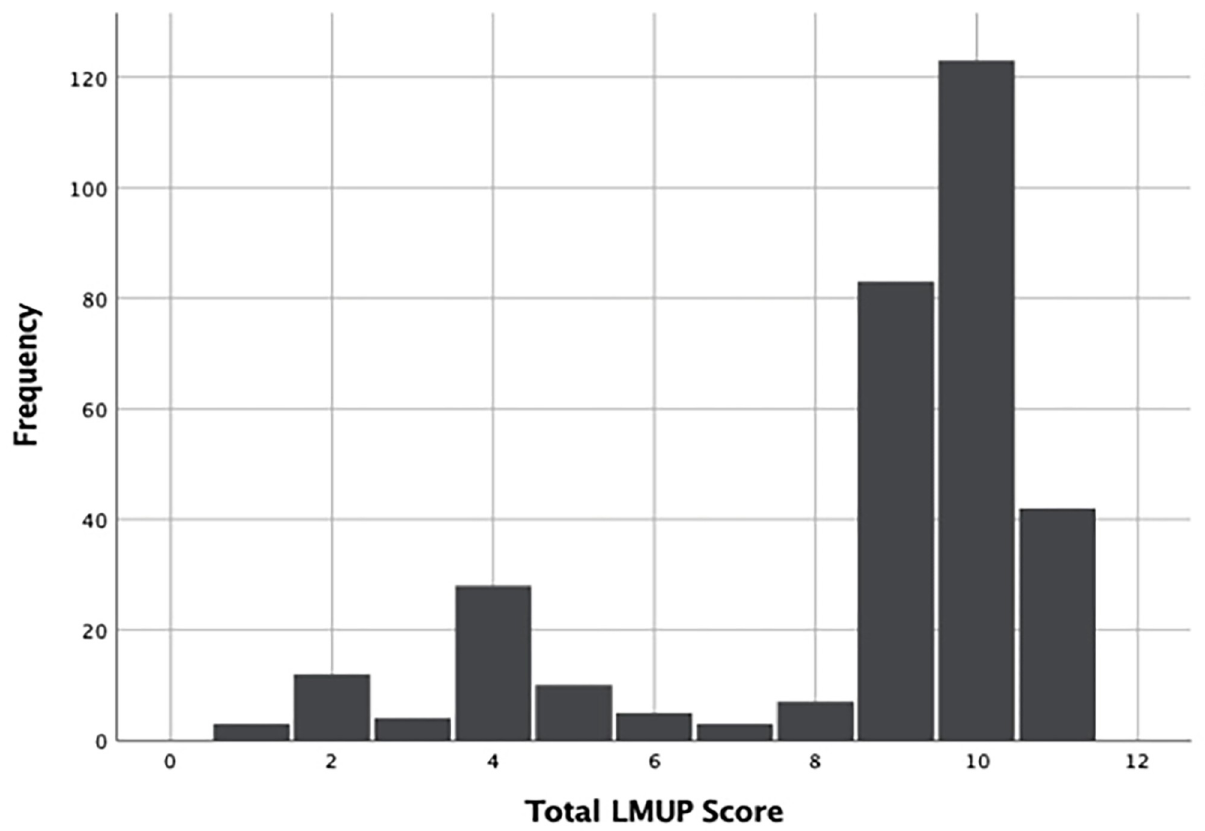
Fig 1. Distribution of Amharic London Measure of Unplanned Pregnancy (LMUP) score.